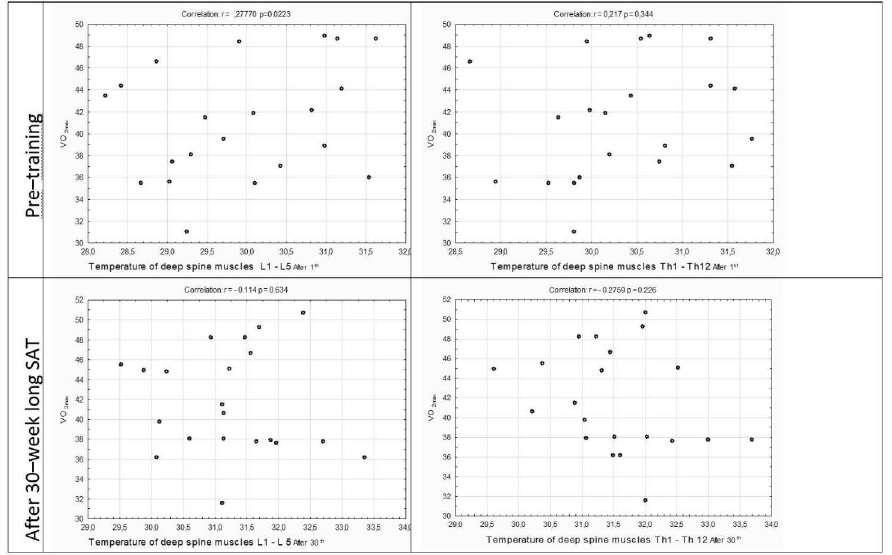
Figure 2. Relationship between the temperature of deep spine muscles L1– L5 and Th1–Th12 vs VO2max index pre-training and after 30-week-long SAT (n =